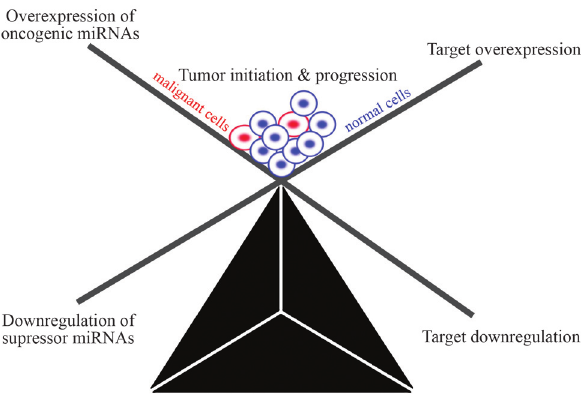
Figure 2 - MicroRNAs (miRNAs) as tumour suppressors and oncogenes. Downregulation or loss of miRNAs with tumour suppressor function may increase translation of oncogenes and hence formation of excess onco- genic proteins, leading to tumour formation. In contrast, upregulation of oncogenic miRNAs may block tumour suppressor genes and also lead to tumour